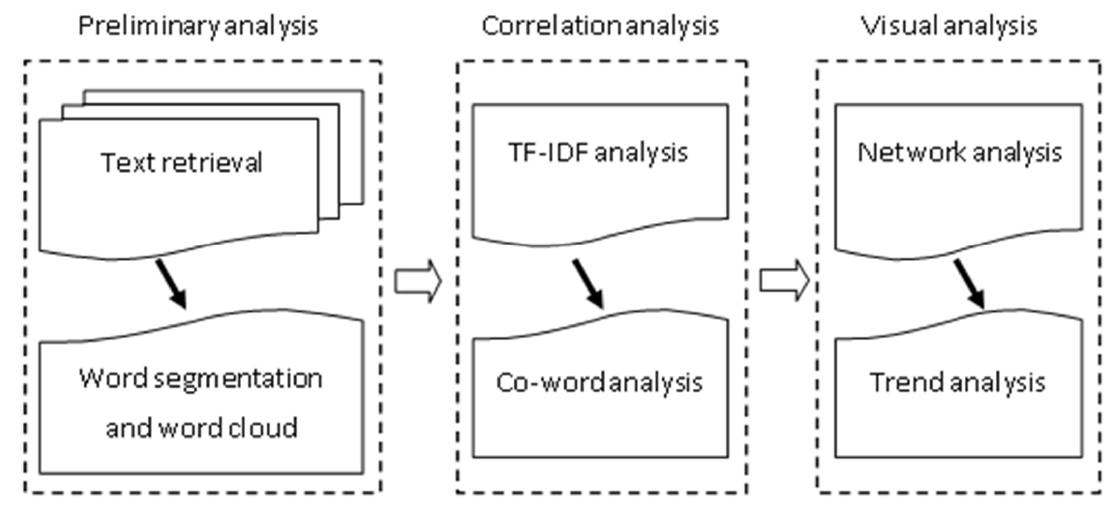
Figure 1. Research flow chart.